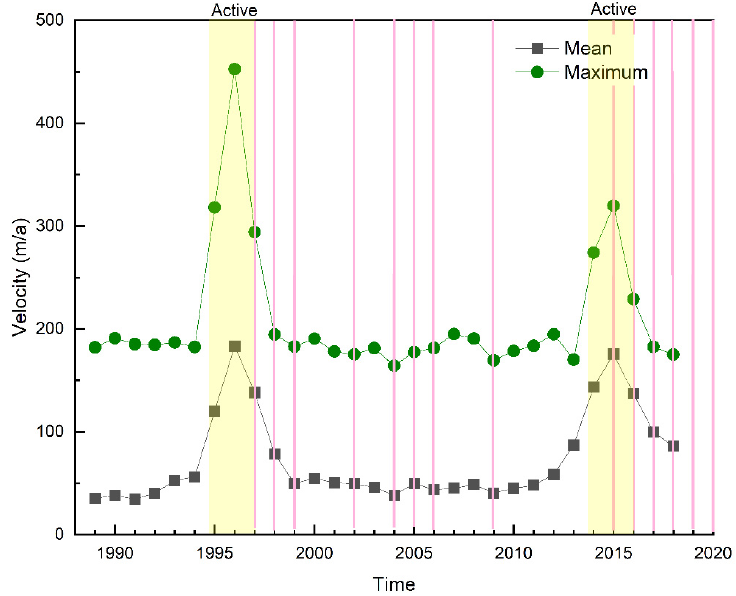
Figure 7. Curves of mean and maximum glacier velocities with time. Pink vertical lines represent GLOF events. Historical GLOF records were from Round et al. [30] and our study. We determine GLOF events based on the disappearance of glacial lakes in remote sensing images. The glacier velocity continued to decrease from 1998 to 2004 (Figure 7), was relatively stable from 2005 to 2009, and increased slightly from 2010 to 2013. Therefore, the period from 1998 to 2009 was the quiescent phase of the last surge, and the period from 2010 to